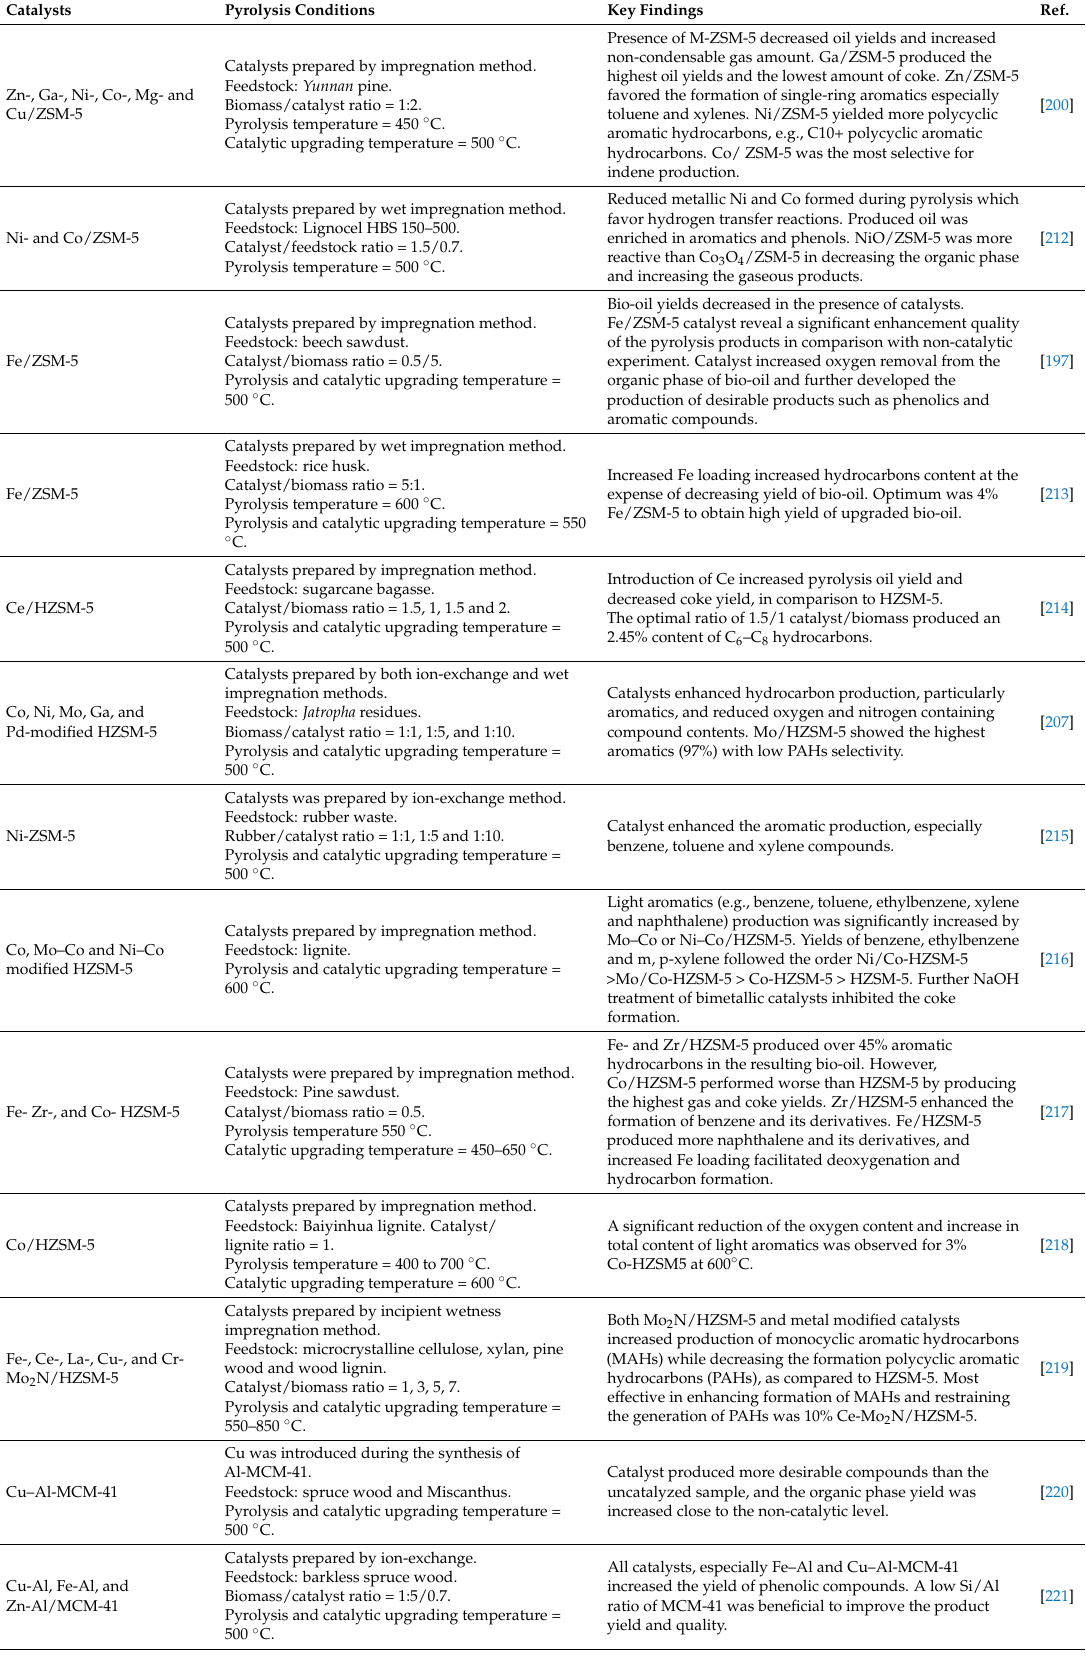
Table 3. Metal doped zeolites used for in-situ catalytic vapor